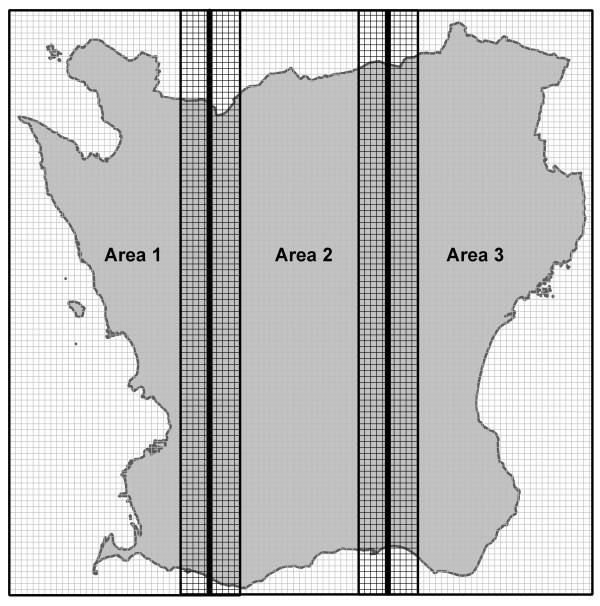
Creating a continuous concentration grid of NO2 for Scania. The mean annual concentrations of NO2 in μg/m3 for Scania were modelled in three separate areas (1–3) each overlapping its neighbouring areas by 10 kilometres to prevent modelling errors in the border areas. These overlaps were later removed and the areas merged into a continuous concentration grid.